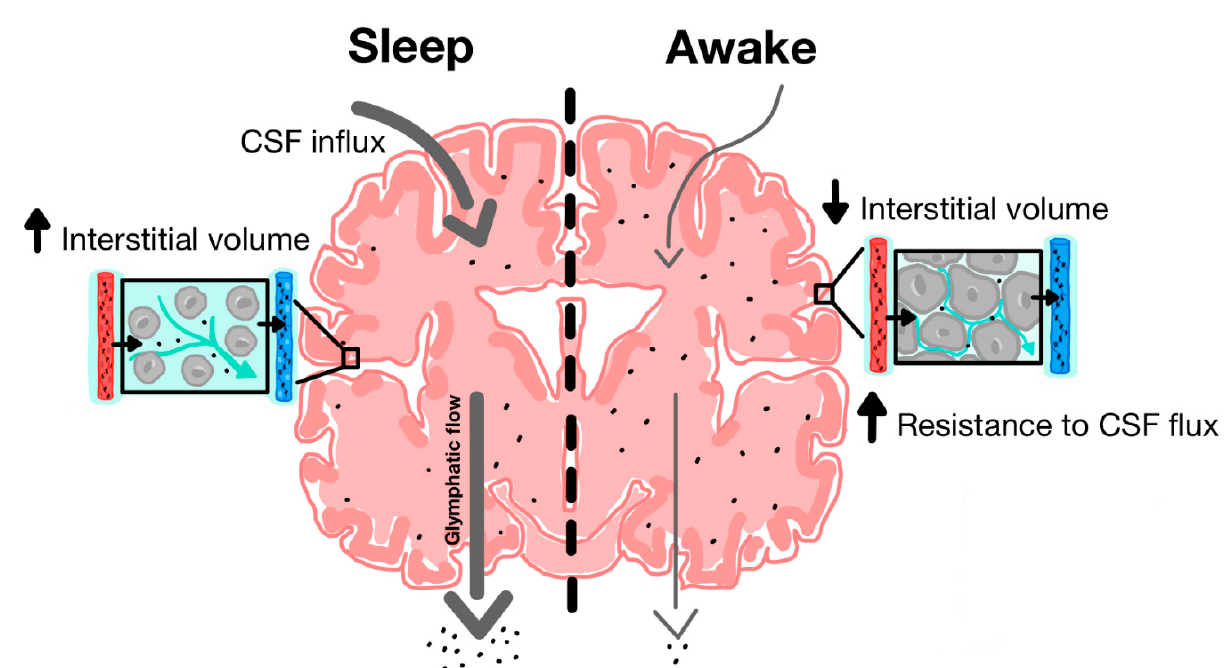
Figure 3. Increased function of glymphatic clearance during sleep compared to wakefulness. During sleep, there is increased CSF influx along periarterial spaces and increased ISF efflux along perivenous spaces. Cytomorphological changes are associated with increased interstitial volume. During wakefulness, there is decreased CSF influx and ISF efflux and most CSF is shunted out along lymphatic pathways due in part to decreased interstitial and perivascular volume [35].